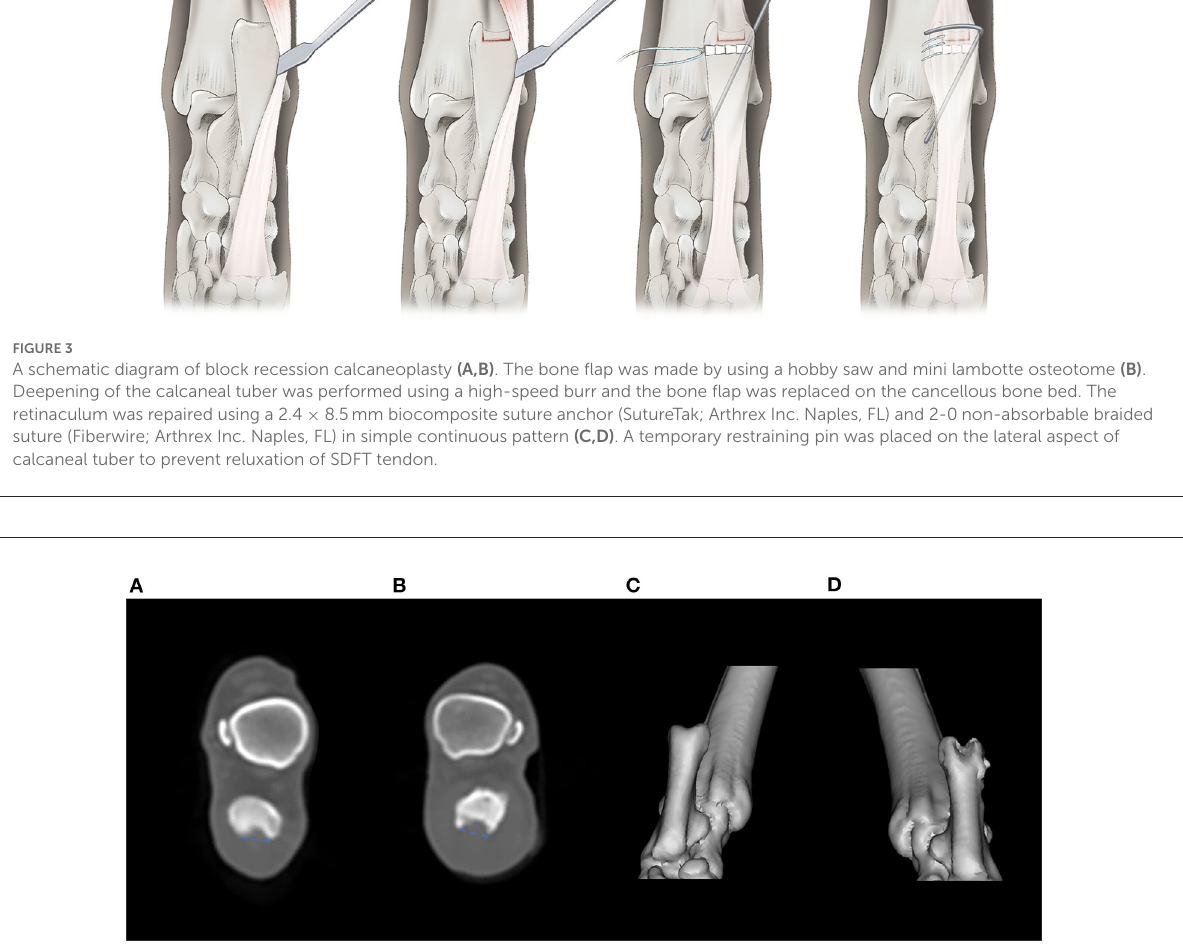
would be less likely to be detected radiographically (Figure